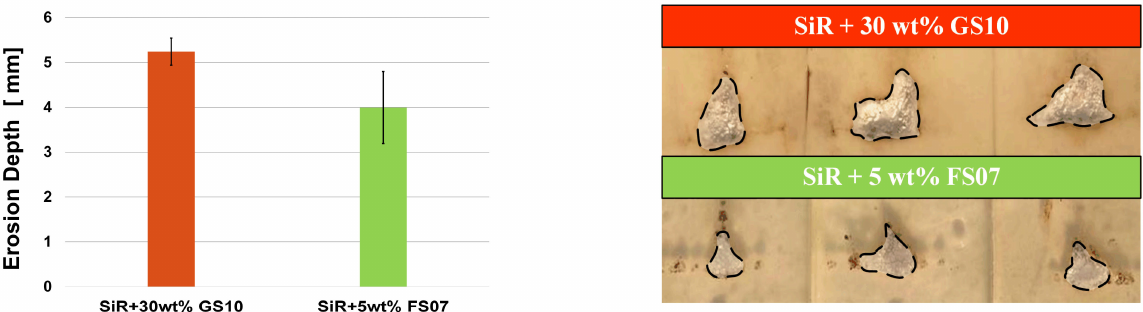
Figure 3. ( a ) +DC IPT erosion depth outcomes for the tested composites. ( b ) Images of the post tested +DC IPT compos- ite